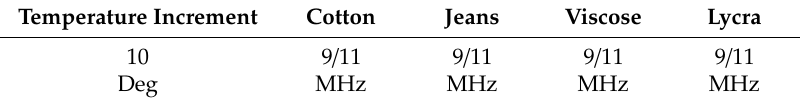
Table 3. Frequency shift over temperature sweep (20–60 ◦ C per 10 ◦ C) at 2.45 GHz (measured